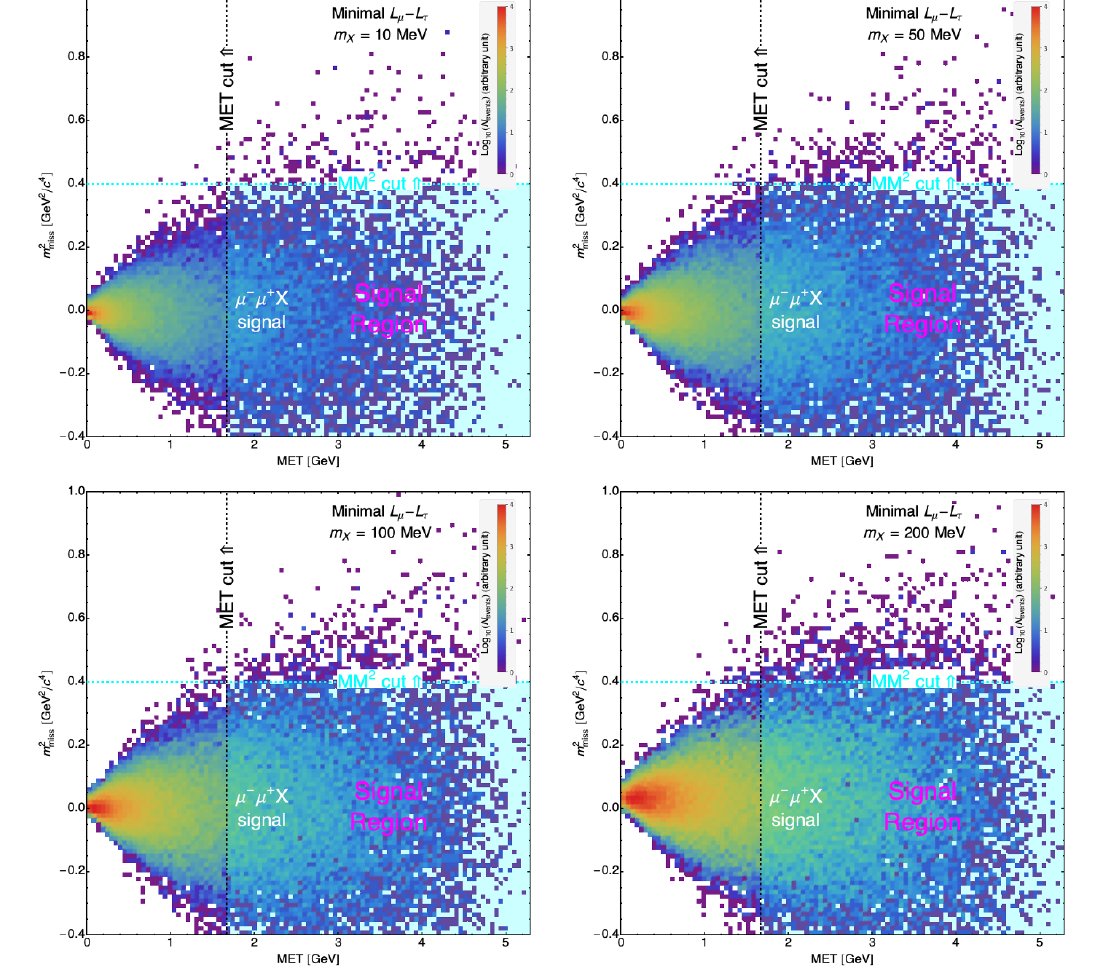
Figure 9 . Distributions of signal events (cid:22) (cid:0) (cid:22) + X on the plane of ( =E 10 ; 50 ; 100 ; 200